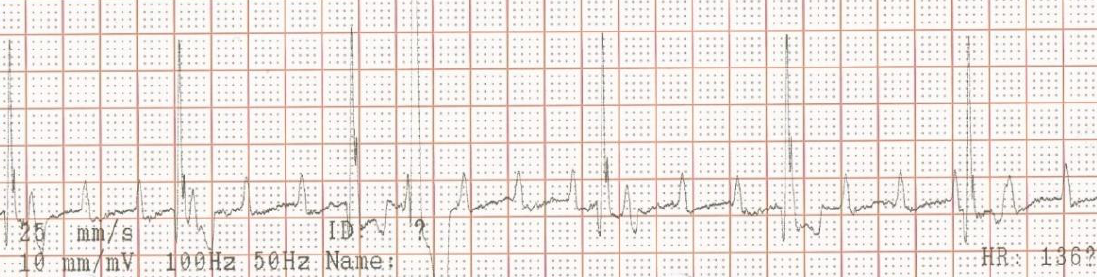
(Hibiscrub, Mölnlycke Health Care, Gothenburg, Sweden). Afterwards, the washed